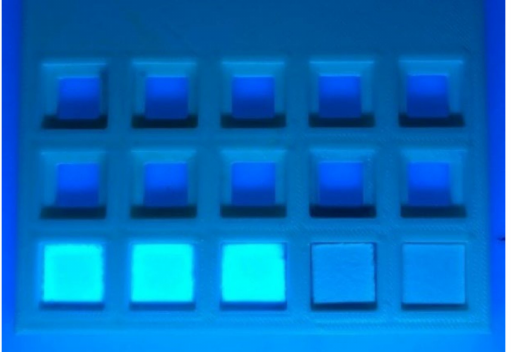
Figure 3. The mold containing CQD paper and ordinary